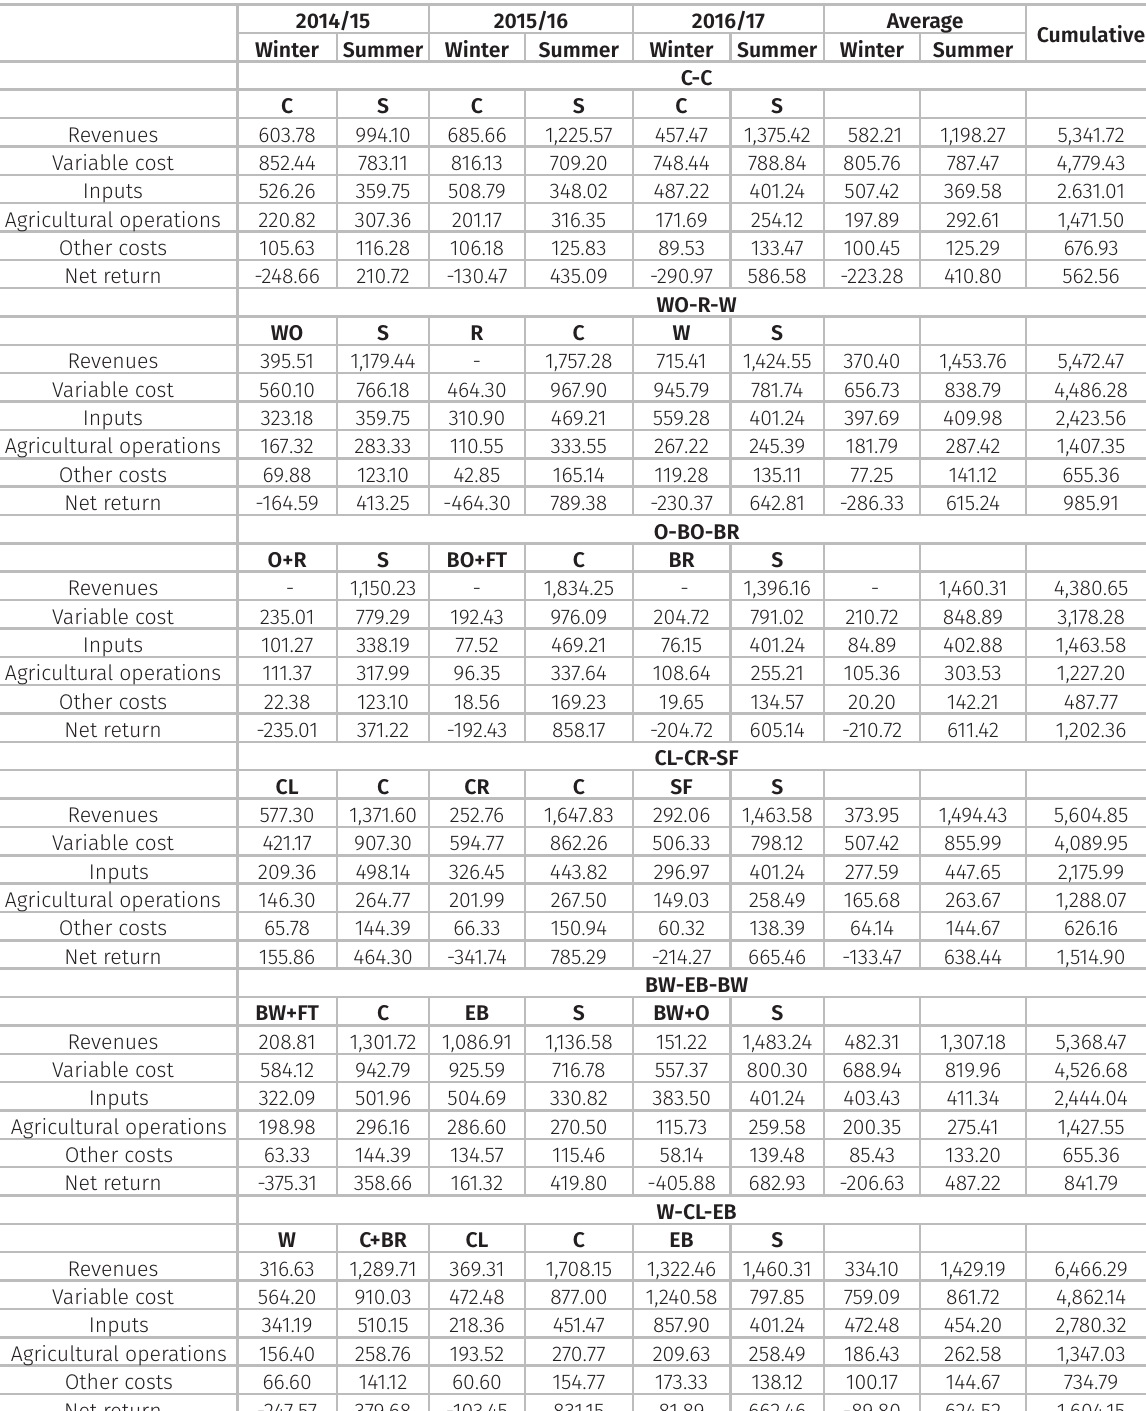
Table III. Revenue, variable cost, and net return (US$ ha -1 ) of production systems, for the crop years 2014/15, 2015/16, and